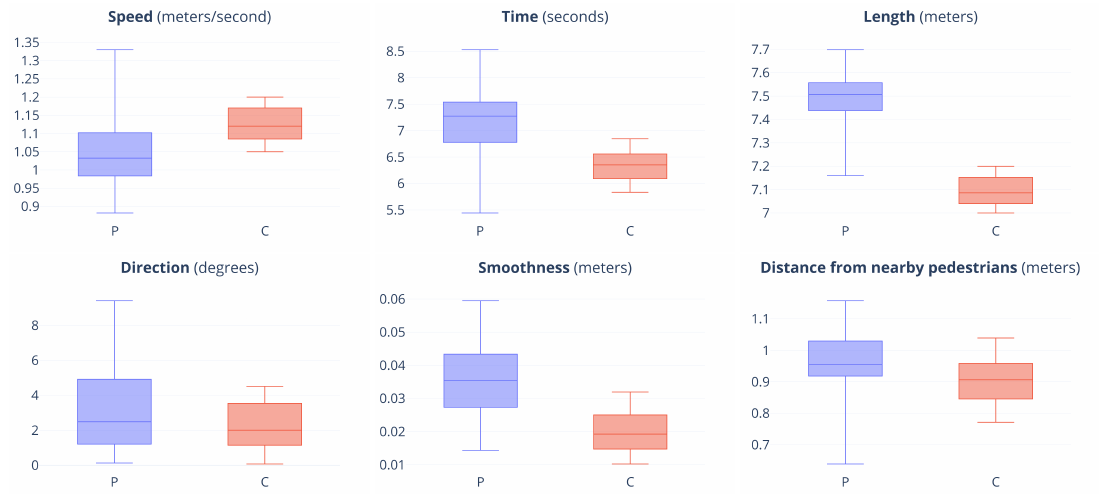
Figure 5. Boxplots of the results of all measurements for the participants (P) and simulated characters (C). Boxes enclose the middle 50% of the data. The median is denoted by a thick horizontal line.